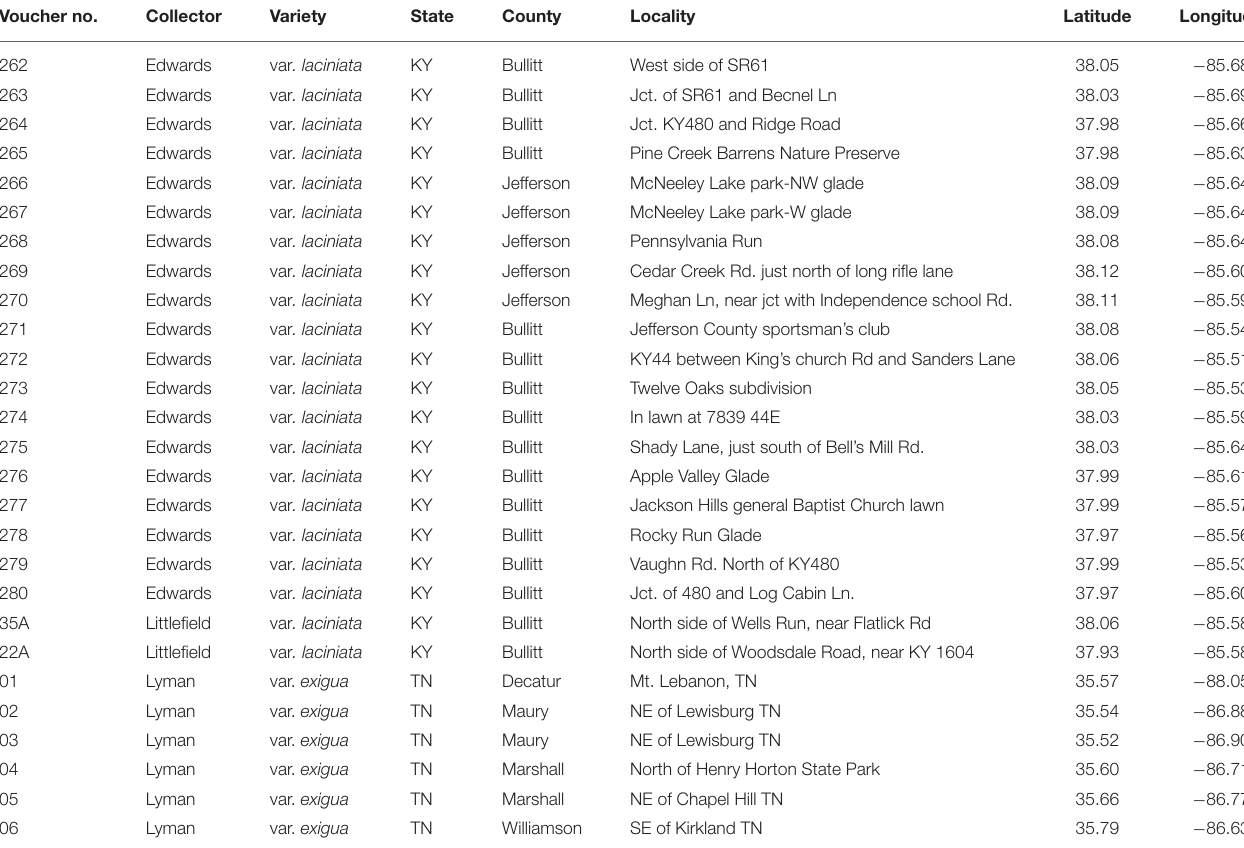
TABLE 1 | Population information for Leavenworthia exigua populations sampled in the study. Voucher